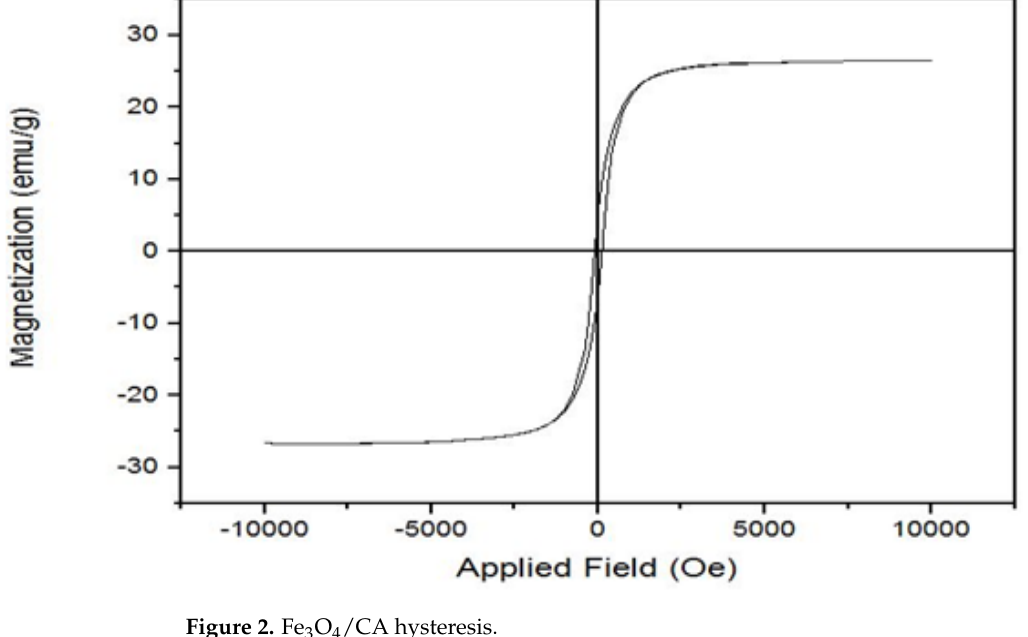
Figure 2. Fe 3 O 4 /CA hysteresis.